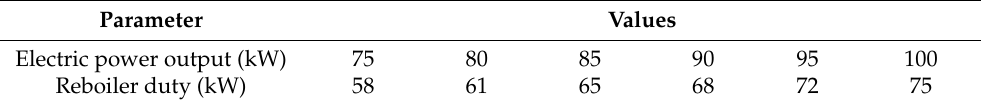
Table 3. Effect of electric power output on reboiler duty (adapted from [67]). Parameter Values Electric power output